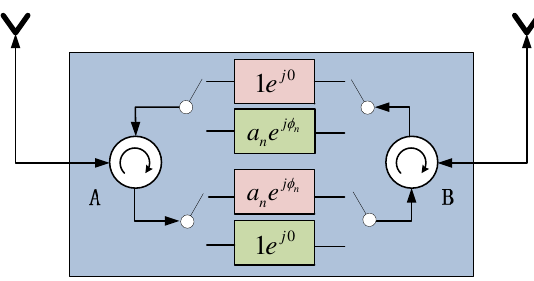
Figure 5. The process of MD modification for modified